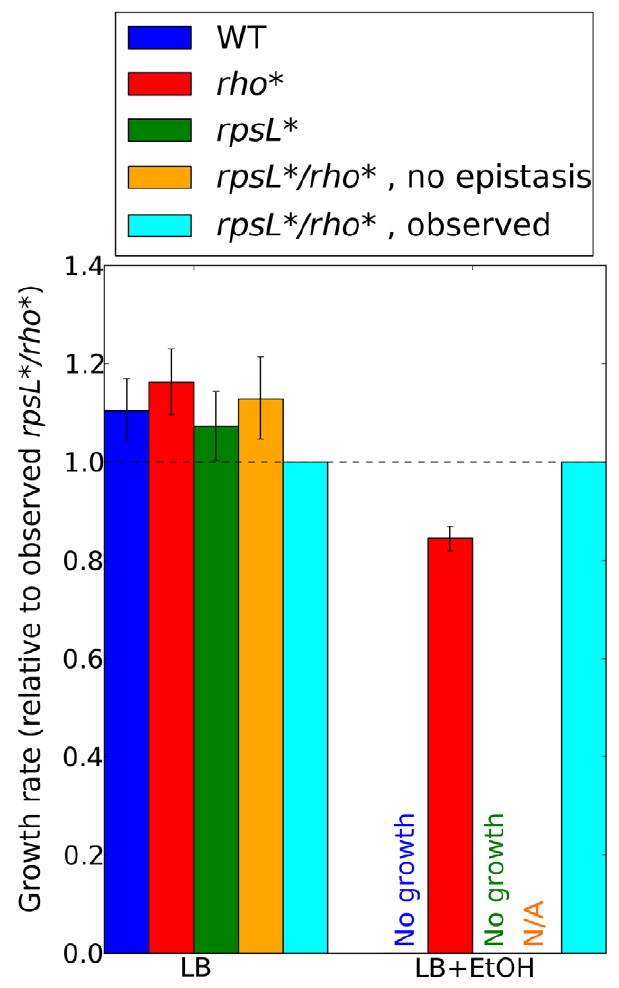
Figure 5. Contributions of rho *- rpsL * epistatic interactions to ethanol tolerance. Ratios of growth rates for each strain to those for the rho */ rpsL * double mutant are shown for all permutations of mutant and wild type alleles at these loci, in LB (left) or LB plus 5.5% ethanol (right). See Section 5 of Text S1 for details on growth rate determination in ethanol-containing media. Error bars indicate 95% confidence intervals. Predictions for the double mutant in the absence of epistasis are made using a multiplicative model (see Text S1, Section 4). Such predictions are not possible in LB + EtOH due to the lack of rho WT and rpsL * growth.